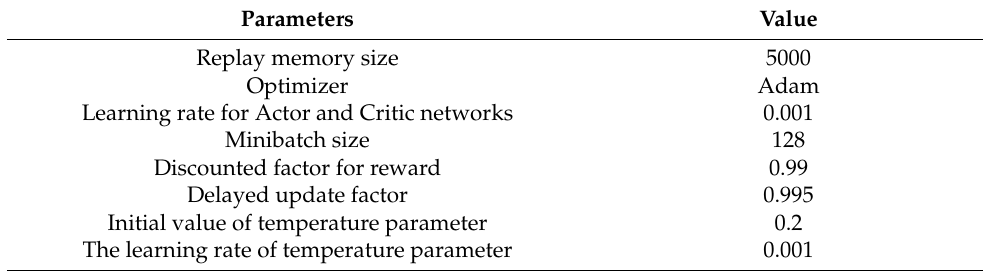
Table 3. Parameters for algorithm implementation.